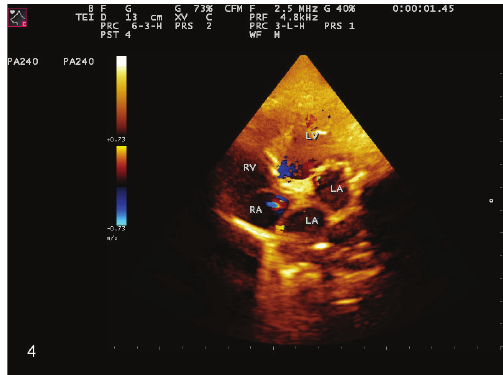
Figure 4: Left apical four-chamber view in systole, showing a transverse membrane and the two left atrial parts ( ∗ LA and ∗∗ LA).